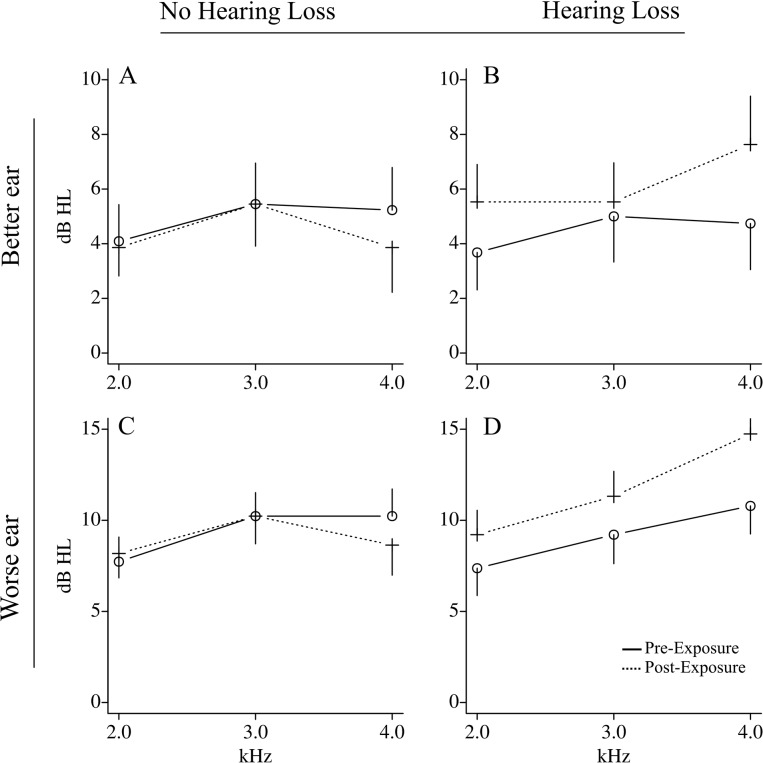
Composite audiograms of the hearing threshold pre- and post-noise exposure.Pre-noise exposure audiograms (circle, full line) and post-noise exposure audiograms (cross, dashed line) are shown for (A) the better ear of subjects without hearing loss; (B) the better ear of subjects with hearing loss; (C) the worse ear of subjects without hearing loss and (D) the worse ear of subjects with hearing loss. Data are the mean dB HL ± s.e.m at frequencies 2, 3 and 4 kHz.